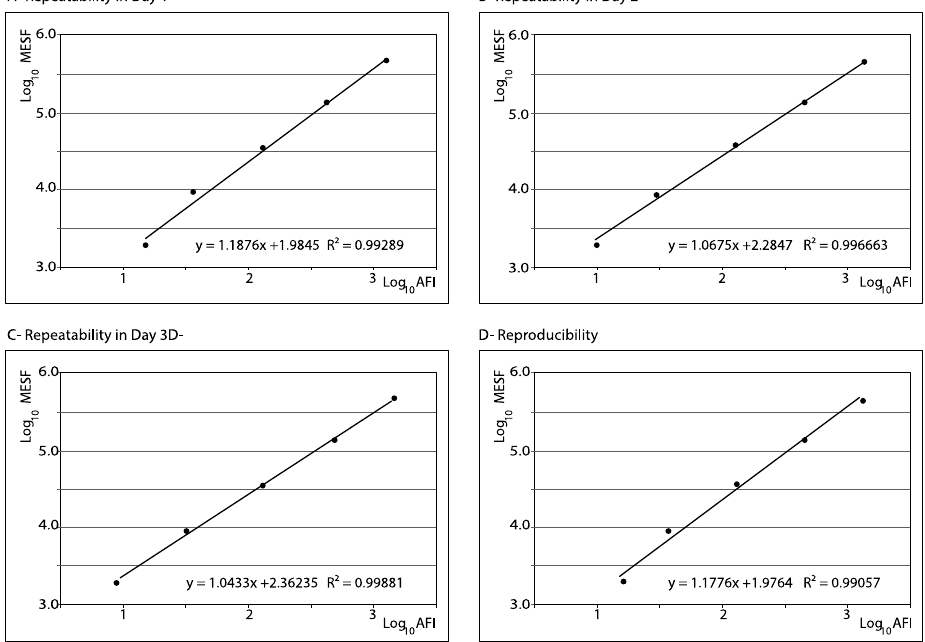
Figure 2. Repeatability and reproducibility. Linear regression between the observed fluorescence (AFI) and the expected MESF reported by the manufacturer of the beads employed as standard.